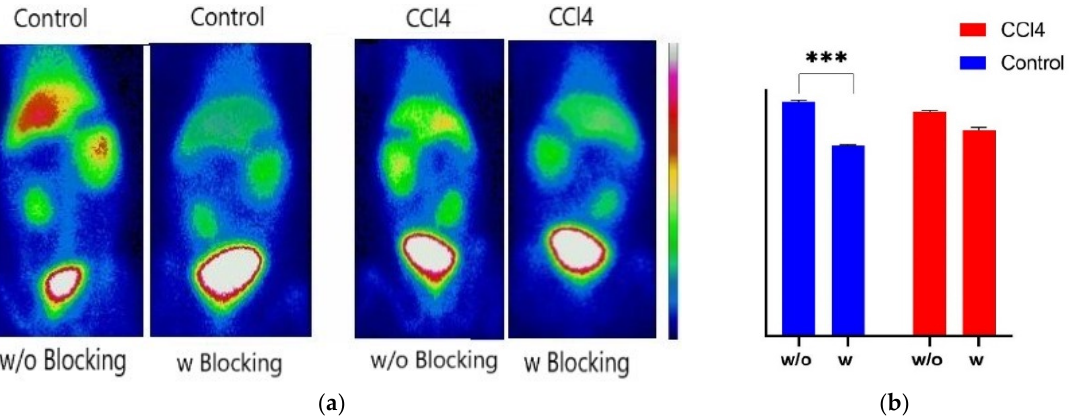
Figure 8. Blocking studies of 99mTc-Q9P35GC in fibrotic mice. ( a ) Representative SPECT image of healthy and fibrotic-liver rabbit at 60 min pi 99mTc-Q9P35GC (80 MBq) with or without Q9P35GC for blocking. Images were adjusted using the same scale for all animals; ( b ) Hepatic uptake of 99mTc-Q9P35GC derived from SPECT imaging by drawing the ROI of the whole liver, uptake is normalized for each group, ‘***’ shows statistically significant difference with p < 0.001.